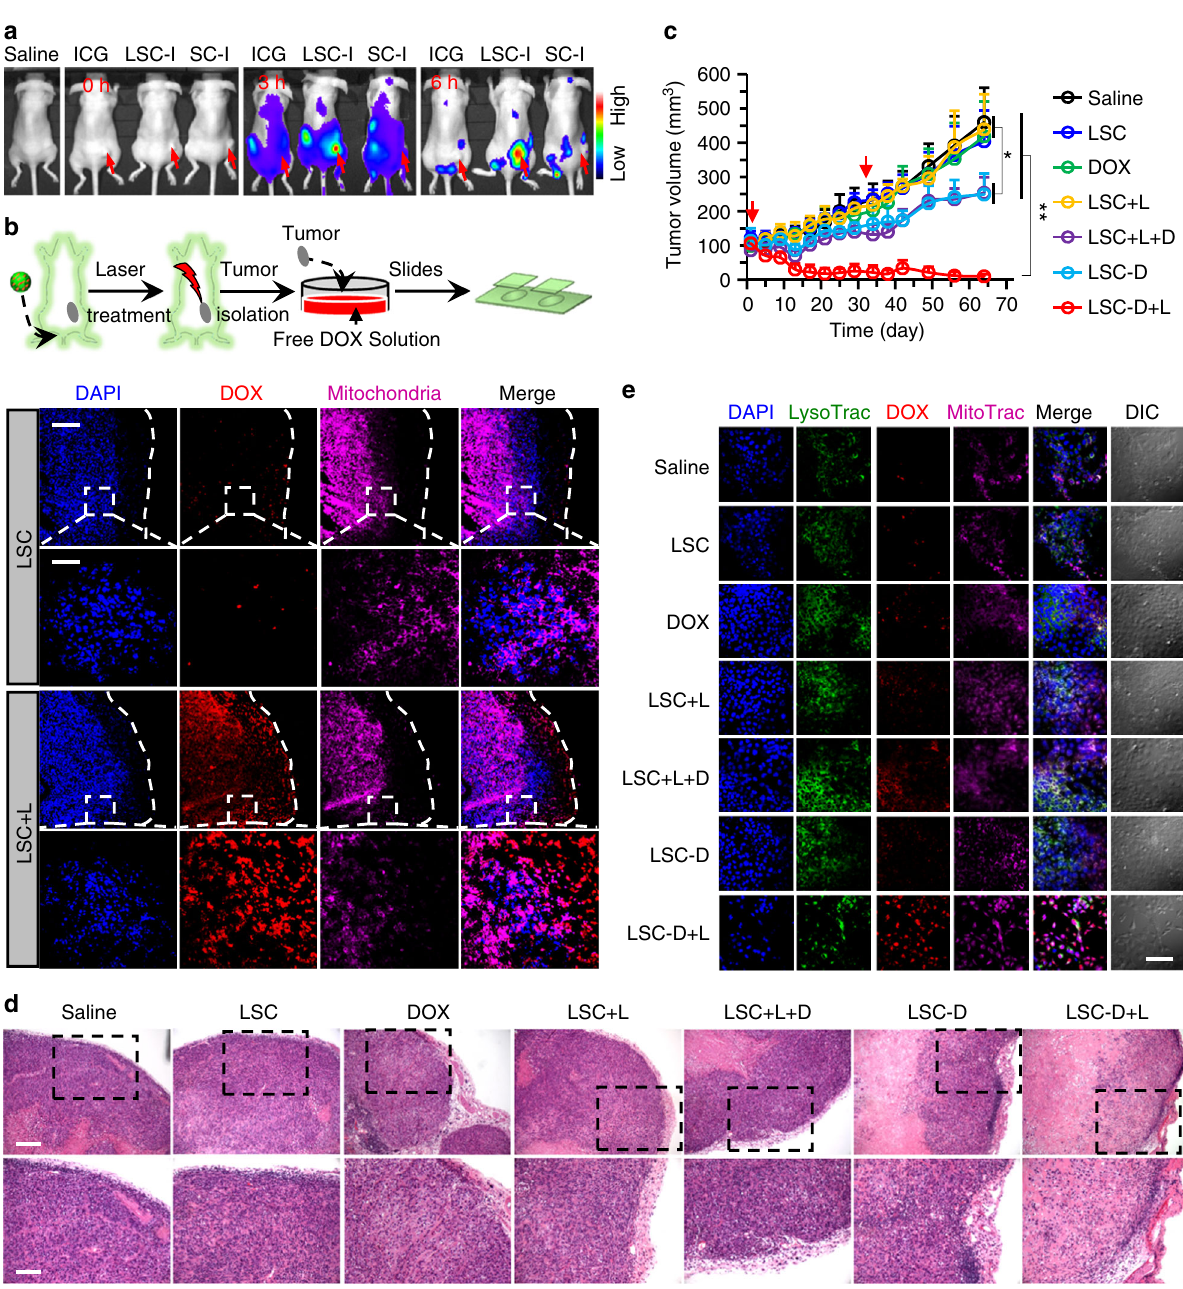
Fig. 7 Overcoming cancer drug resistance and augmenting cancer destruction in vivo. a In vivo whole-animal imaging of indocyanine green (ICG) fl uorescence at different times after intravenous injection via the tail vein in the form of free ICG, ICG-laden LSC (LSC-I) nanoparticles, and ICG-laden SC (SC-I) nanoparticles. The arrows indicate the locations of tumors in mice. b Fluorescence images of DOX in tumors of mice killed at 24 h post injection with LSC nanoparticles (with and without laser irradiation right before killing the mice). The data suggest the capability of overcoming cancer drug resistance could be achieved in vivo with the LSC + L treatment. The dashed lines indicate the boundary of the tumor tissue. The boxed regions are shown in higher magni fi cation. Scale bar: 200 and 50 μ m for low and high magni fi cation images, respectively. c Growth curves of tumors in mice with various treatments showing augmented antitumor ef fi cacy of the LSC-D + L treatments. Error bars represent s.d. ( n = 7). ** p < 0.01, * p < 0.05 (Kruskal – Wallis H -test). d Representative images of hematoxylin and eosin (H&E)-stained tumor tissue collected after killing the mice on day 64 after the fi rst drug administration. Scale bar: 100 and 50 μ m for low and high magni fi cation images, respectively. e Fluorescence images of DOX in cells isolated form tumors collected on day 64 from mice with different treatments. The cells were incubated with DOX for 3 h. The data show that the drug-resistant capability of the multidrug- resistant cells in the tumors with the LSC-D + L treatment is still not fully recovered. Scale bar: 80 μ m. All non-speci fi ed NIR laser (L) irradiation was at 1 W cm − 2 for 2 min. Detached NCI/RES-ADR sphere cells enriched with CSCs were used to obtain xenograft tumors for all in vivo